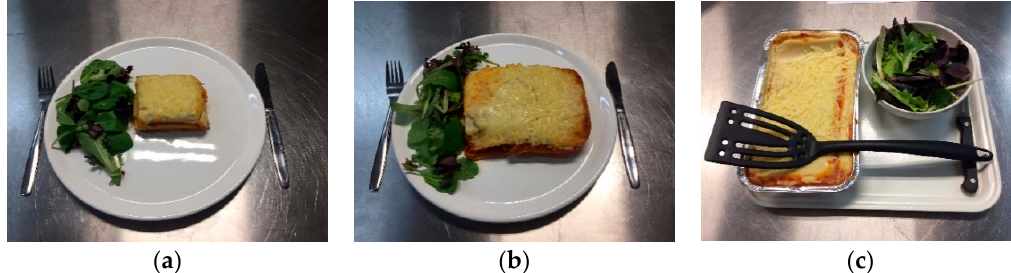
Figure 2. Lasagna served in Study 2: ( a ) Smaller portion size (180 g cooked lasagna, 292 kcal); ( b ) larger portion size (540 g cooked lasagna, 875 kcal); and ( c ) family-sized lasagna (978 g cooked lasagna, 1584